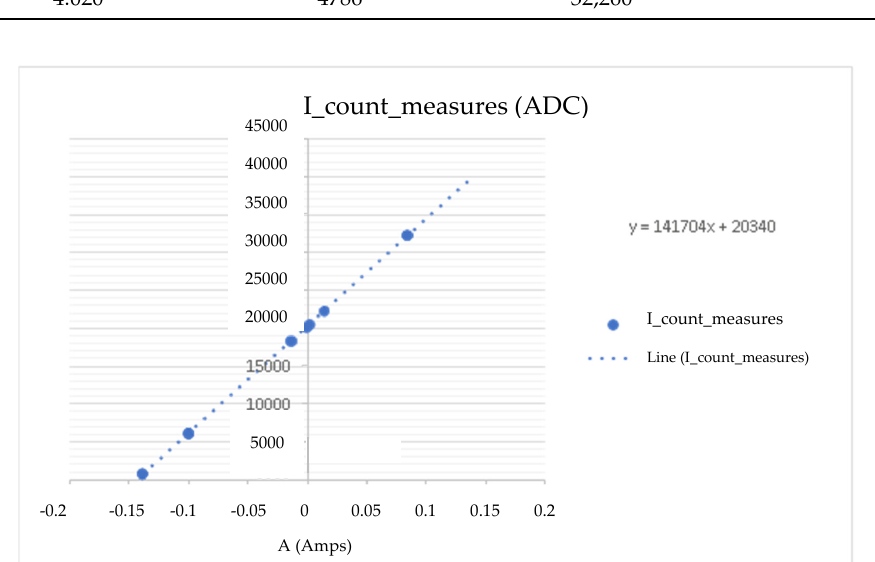
Figure 5. “I” counts measured at the ADC.